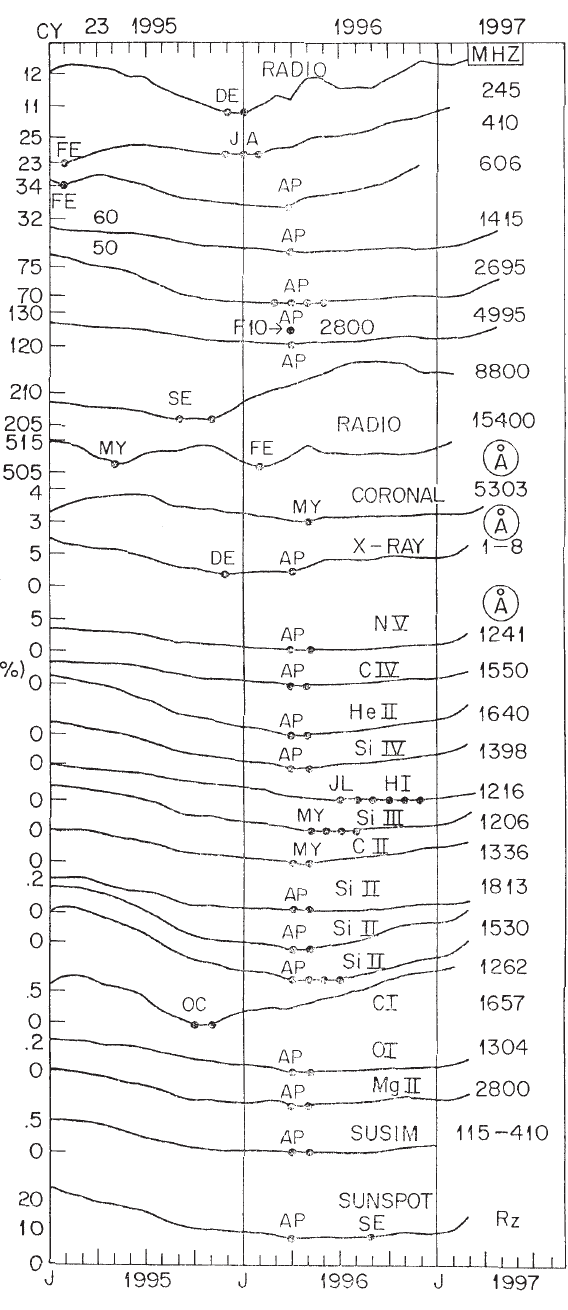
Fig. 11. Plots of the 12-month moving averages of various chromo- spheric line indices and coronal radio emission indices during years of sunspot minimum of cycle 23,